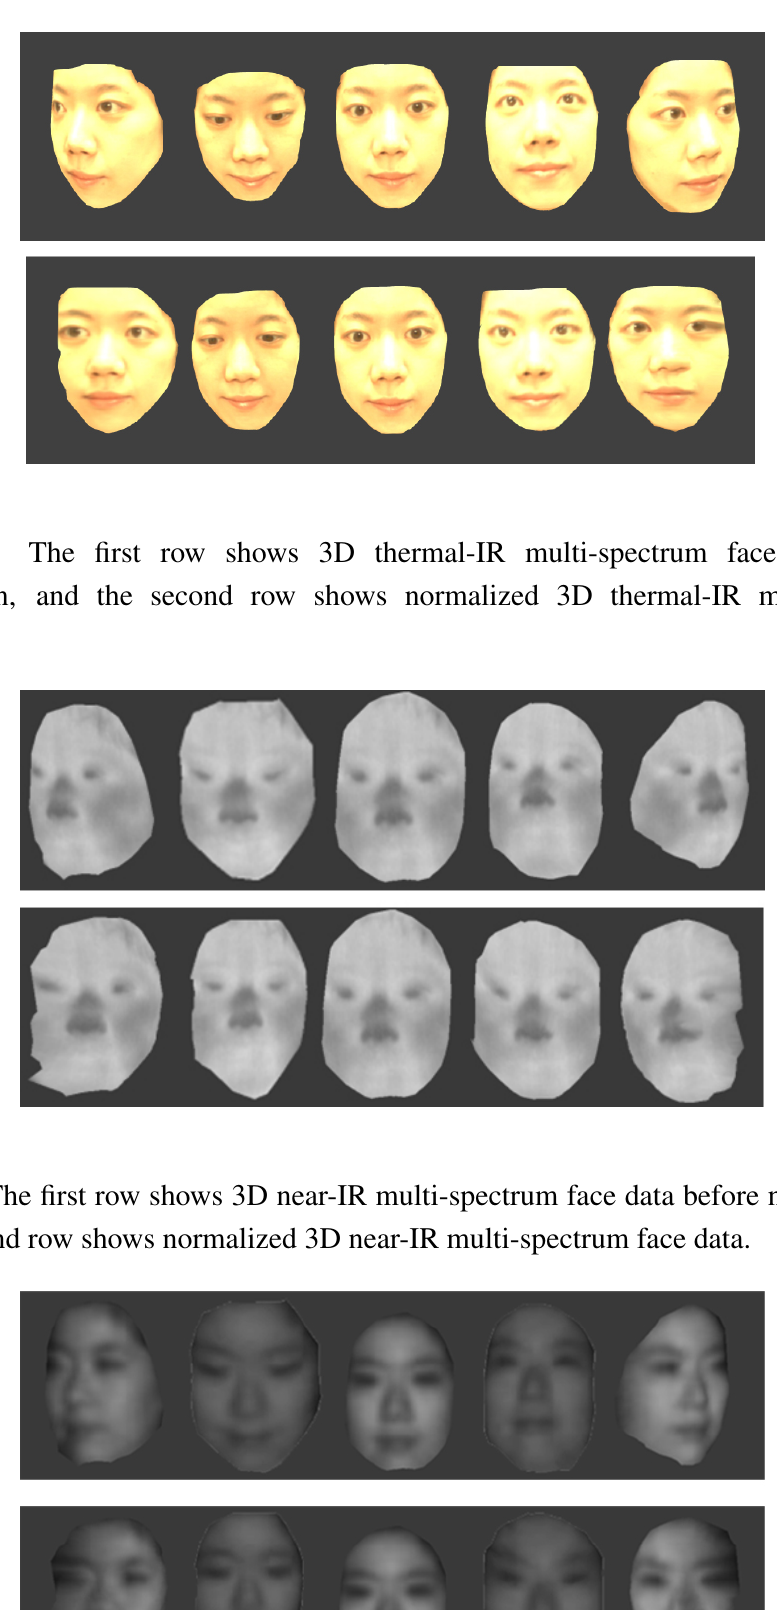
Figure 17. The first row shows 3D visible multi-spectrum face data before normalization and the second row shows normalized 3D visible multi-spectrum face data.